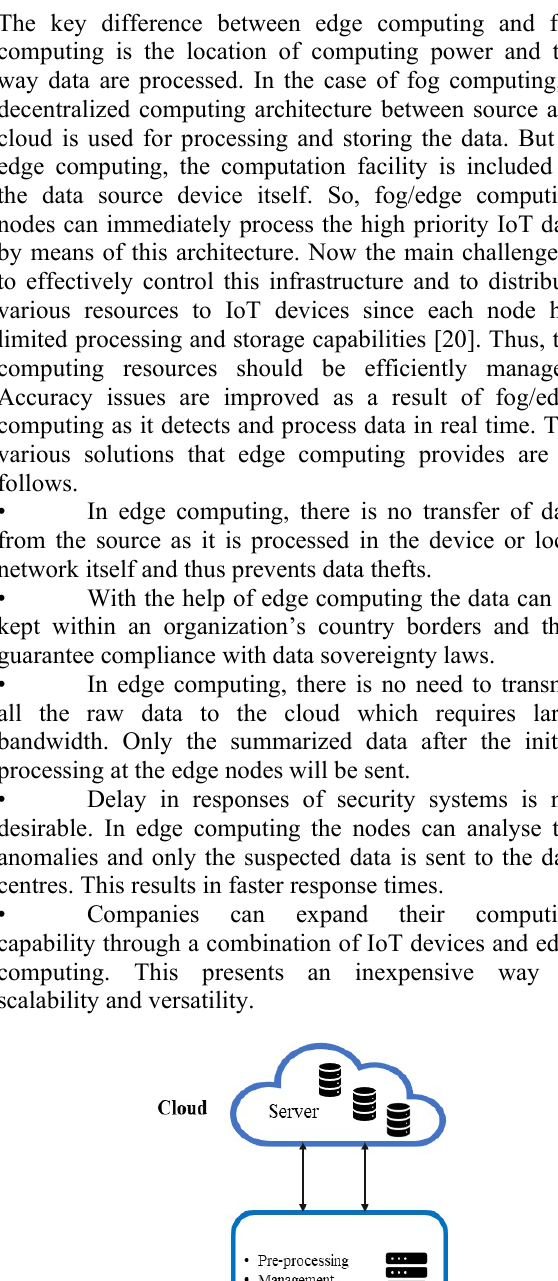
figure 7. Both cloud computing and fog computing aids machine-to-machine